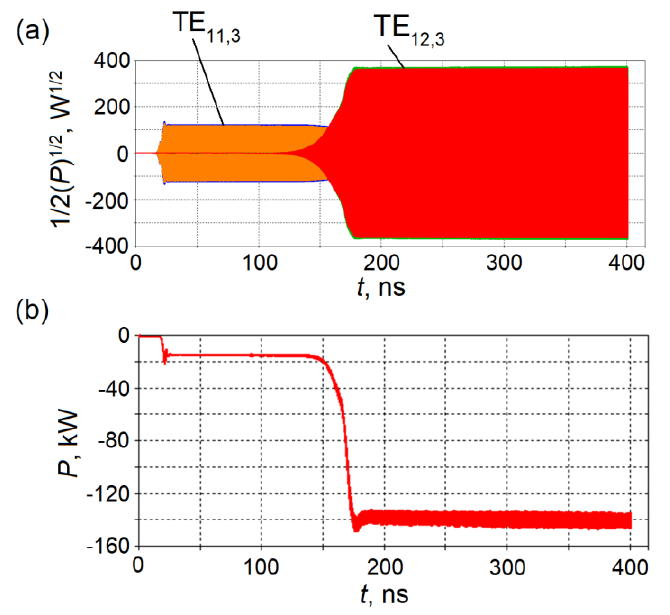
Fig. 2. Time dependence of output port signal in various modes excited in the resonator (a) and wave- particle power transfer